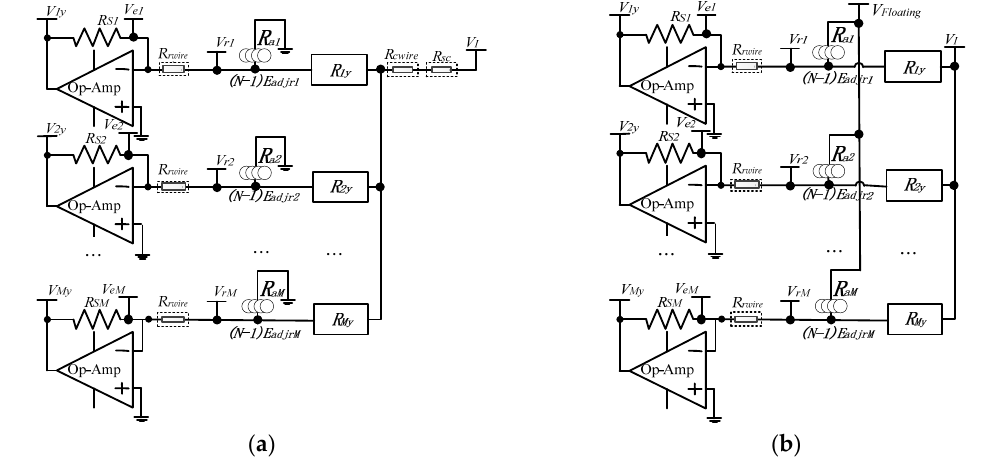
Figure 1. ( a ) Equivalent circuit model of the multi ‐ channel one ‐ wire readout circuit (Model A); ( b ) Equivalent circuit model of the multi ‐ channel part two ‐ wire readout circuit (Model B).